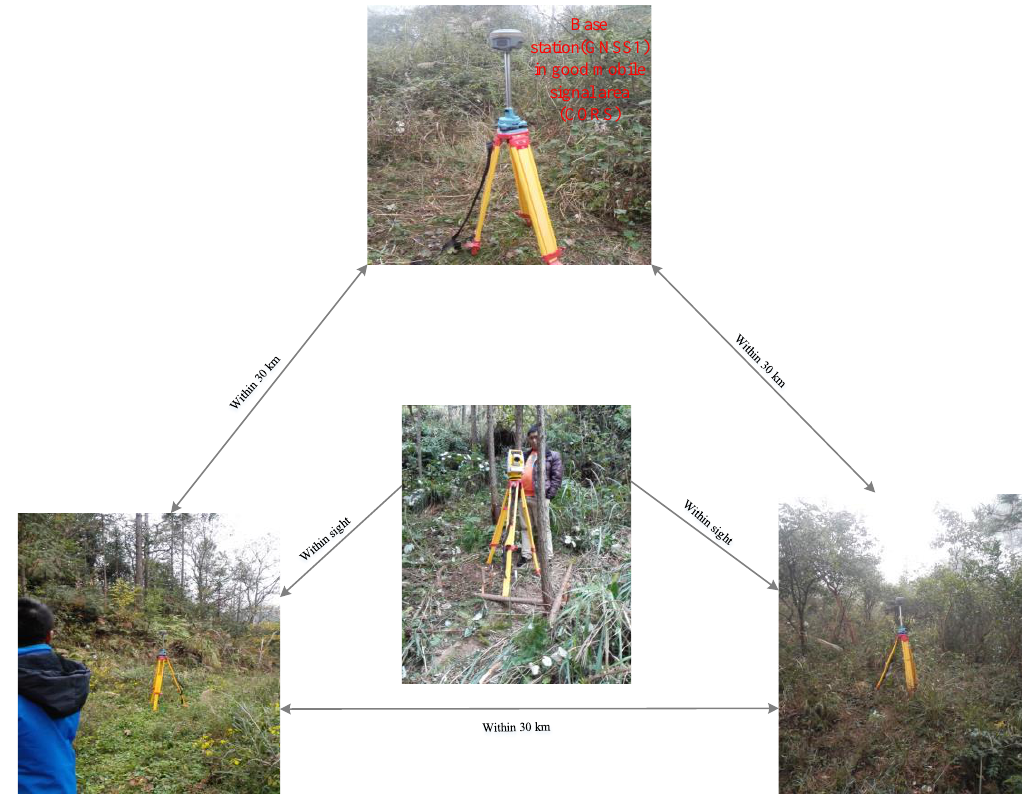
Figure 2. TBSJDPT workflow diagram for a given field sample plot.